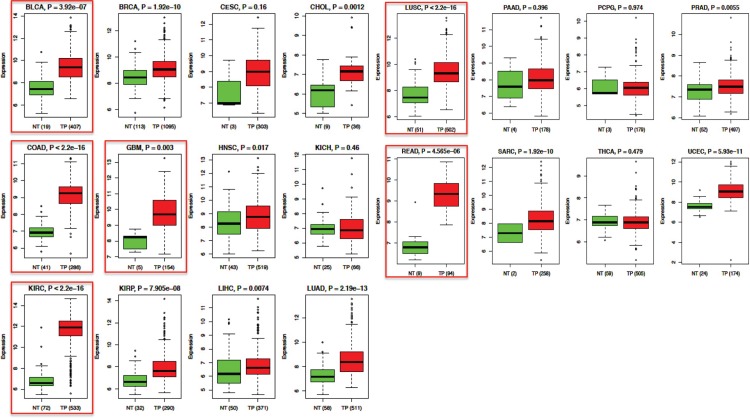
Differential expression of HIG2 mRNA in tumor specimens and adjacent normal tissues.Compare HIG2 expression between tumor and matched normal tissue in 20 TCGA cancer types. The expression values of HIG2 were downloaded from the UCSC (University of California, Santa Cruz) cancer browser (https://genome-cancer.ucsc.edu/). Gene expression was reported as Log2. P values were calculated using two-tailed unpaired Student t-test. Number in round brackets indicates ‘number of patients’. NT = matched normal tissue; TP = primary tumor tissue. BLCA, bladder urothelial carcinoma; BRCA, breast invasive carcinoma; CESC, cervical squamous cell carcinoma and endocervical adenocarcinoma; CHOL, cholangiocarcinoma; LUSC, lung squamous cell carcinoma; PAAD, pancreatic adenocarcinoma; PCPG, pheochromocytoma and paraganglioma; PRAD, prostate adenocarcinoma; COAD/READ, colon/rectum adenocarcinoma; GBM, glioblastoma multiforme; HNSC, head and neck squamous cell carcinoma; KICH, kidney chromophobe; SARC, sarcoma; THCA, thyroid carcinoma; UCEC, uterine corpus endometrial carcinoma; KIRC, kidney renal clear cell carcinoma; KIRP, kidney renal papillary cell carcinoma; LIHC, liver hepatocellular carcinoma; LUAD, lung adenocarcinoma.